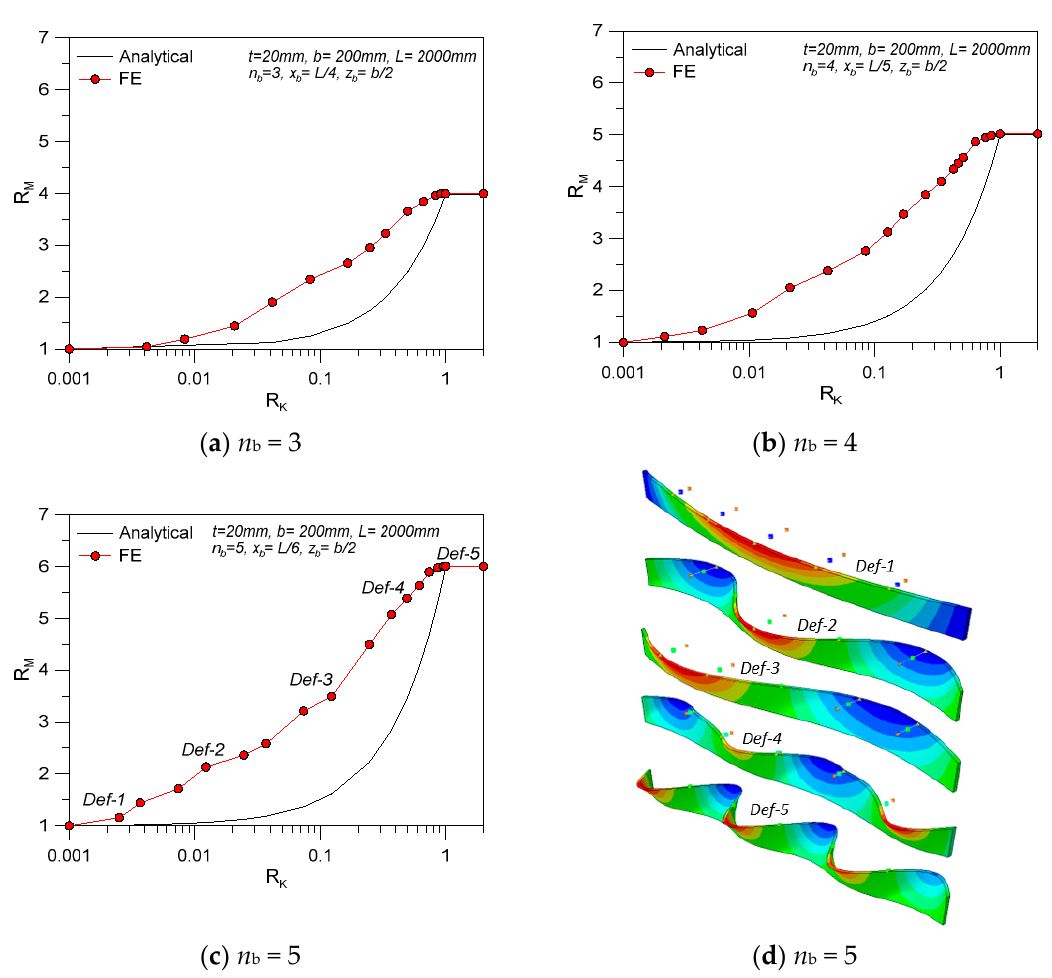
Figure 21. Comparative LTB calculations for LR glass beams with n b > 1 discrete lateral restraints (with K = var): effects on ( a – c ) theoretical resistance and ( d ) selected critical deformed shapes (ABAQUS).